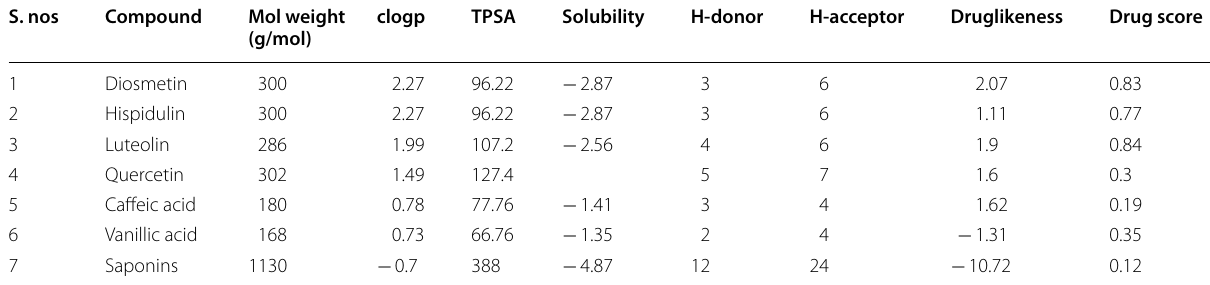
Properties of the selected natural compounds show that diosmetin, hispidulin, and luteolin show better drug properties, whereas luteolin with molecular weight 286 g/mol shows best properties as compared to other compounds